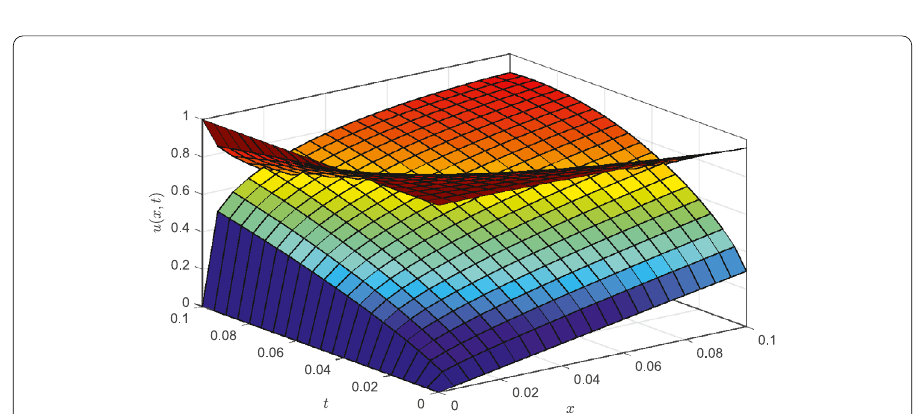
Figure 2 The approximate solution of Example 1 for Case 1 and α = β =